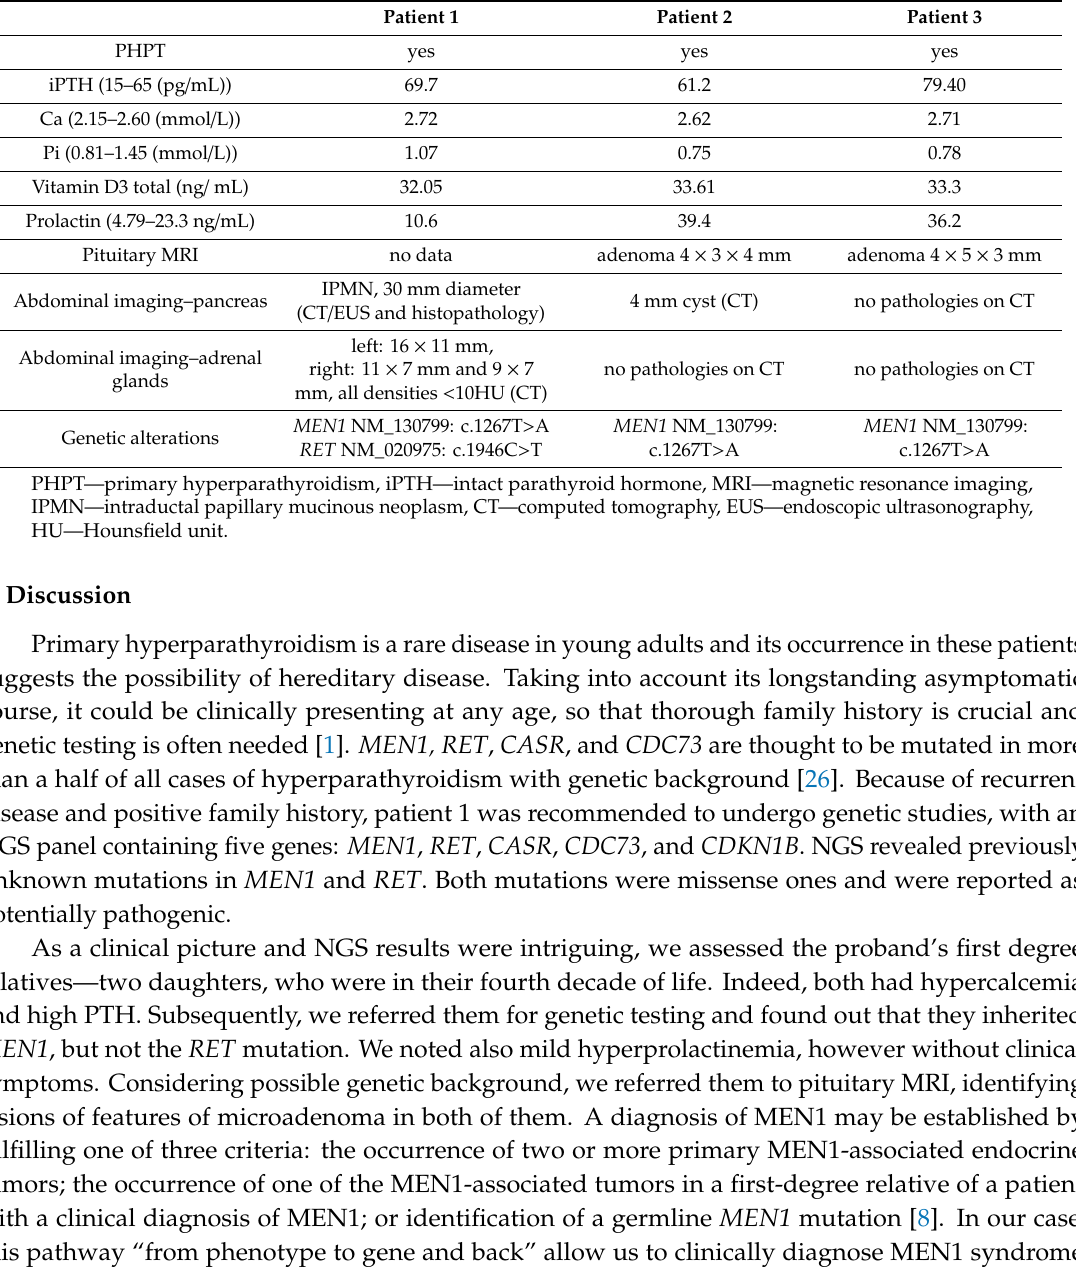
Table 2. Abnormalities found in the